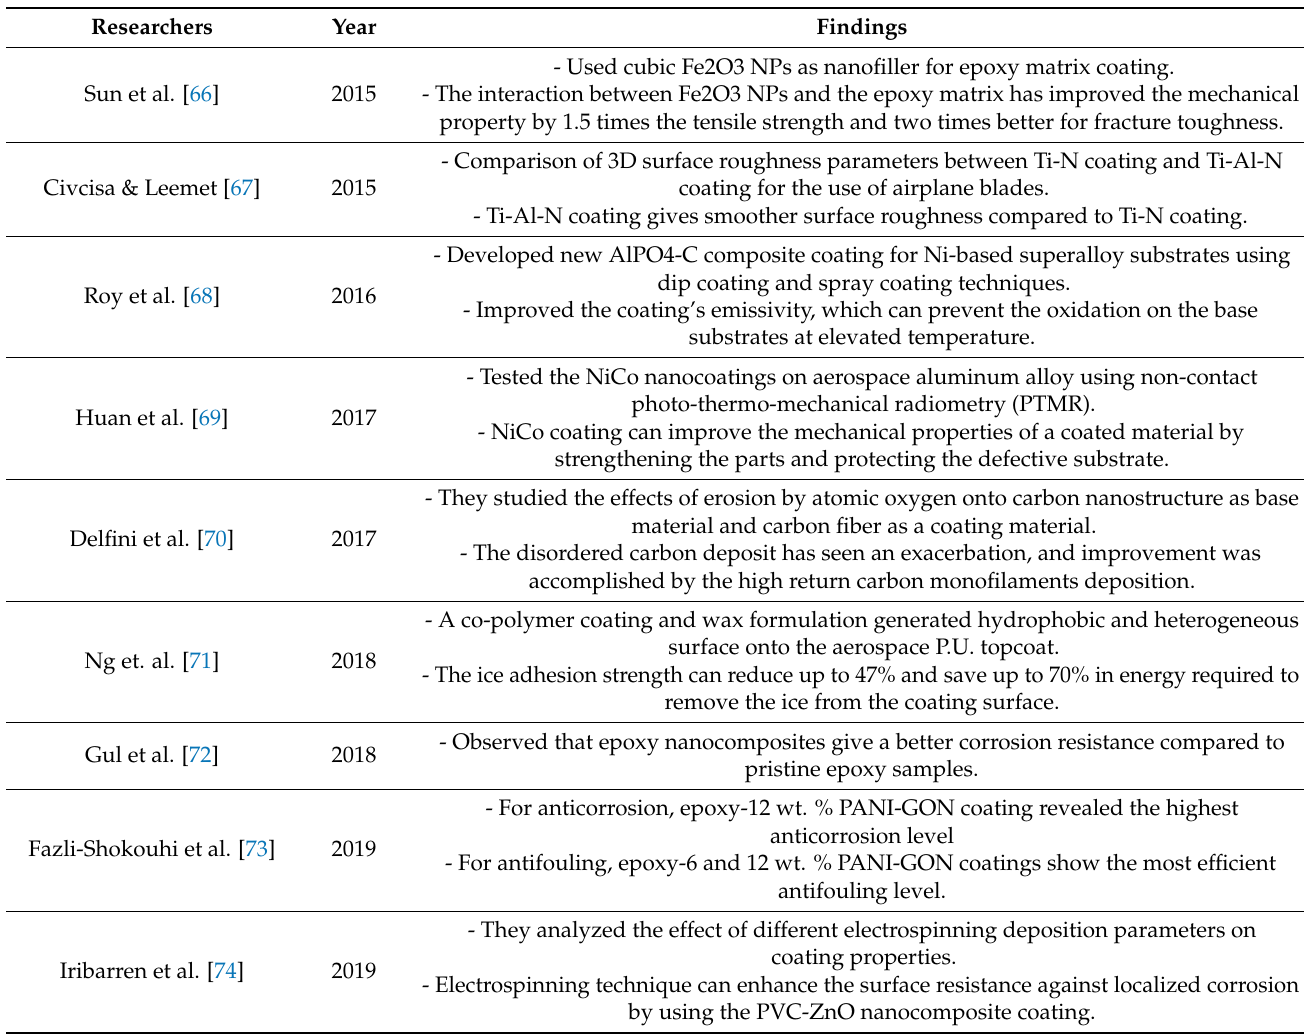
Table 3. Previous research work on nanocoatings for aerospace application.